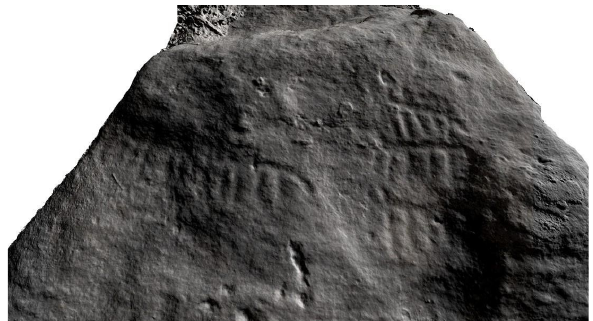
Figure 2: Snapshot from the 3D scan model of the same panel as in Figure 1, with the simulation of raking light.